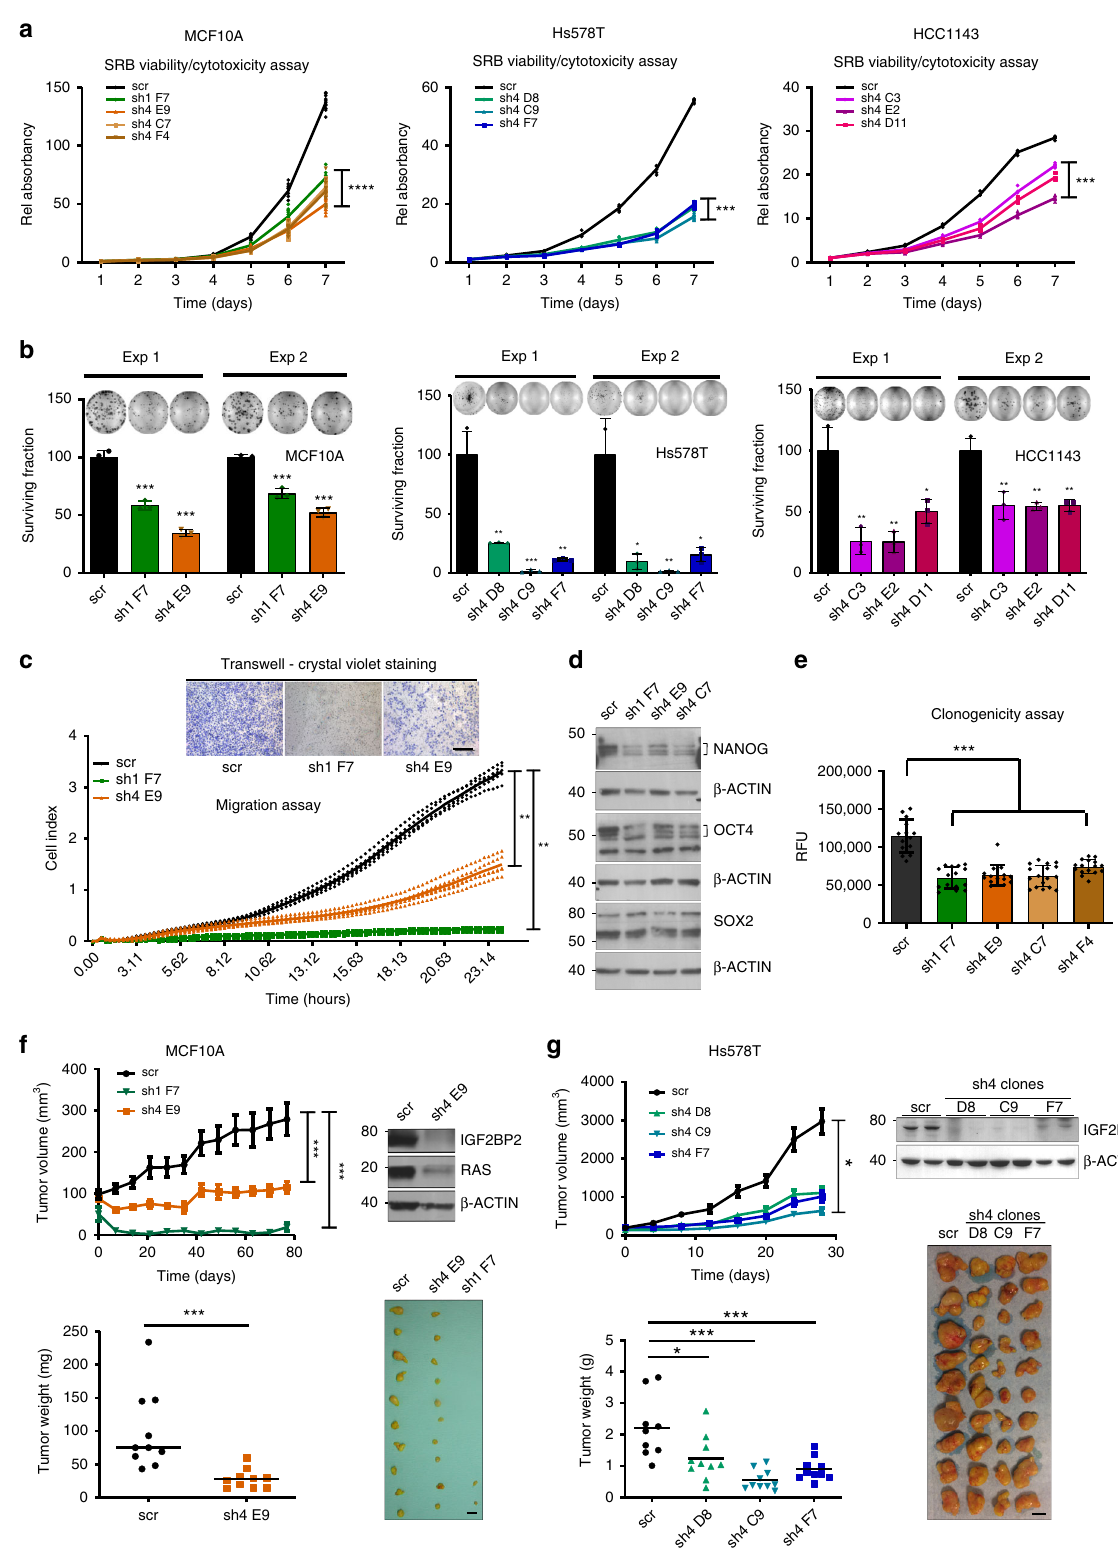
moderately reduced (Fig. 4d, lower panel). In this case, RPSAP52 knockdown did not correlate with IGF2BP2 decrease, but with a marked reduction in LIN28B protein levels, which in contrast to breast cell lines, is abundantly expressed in A673 cells (Fig. 4e and Supplementary Fig. 4e). Also, while RAS levels were only partially